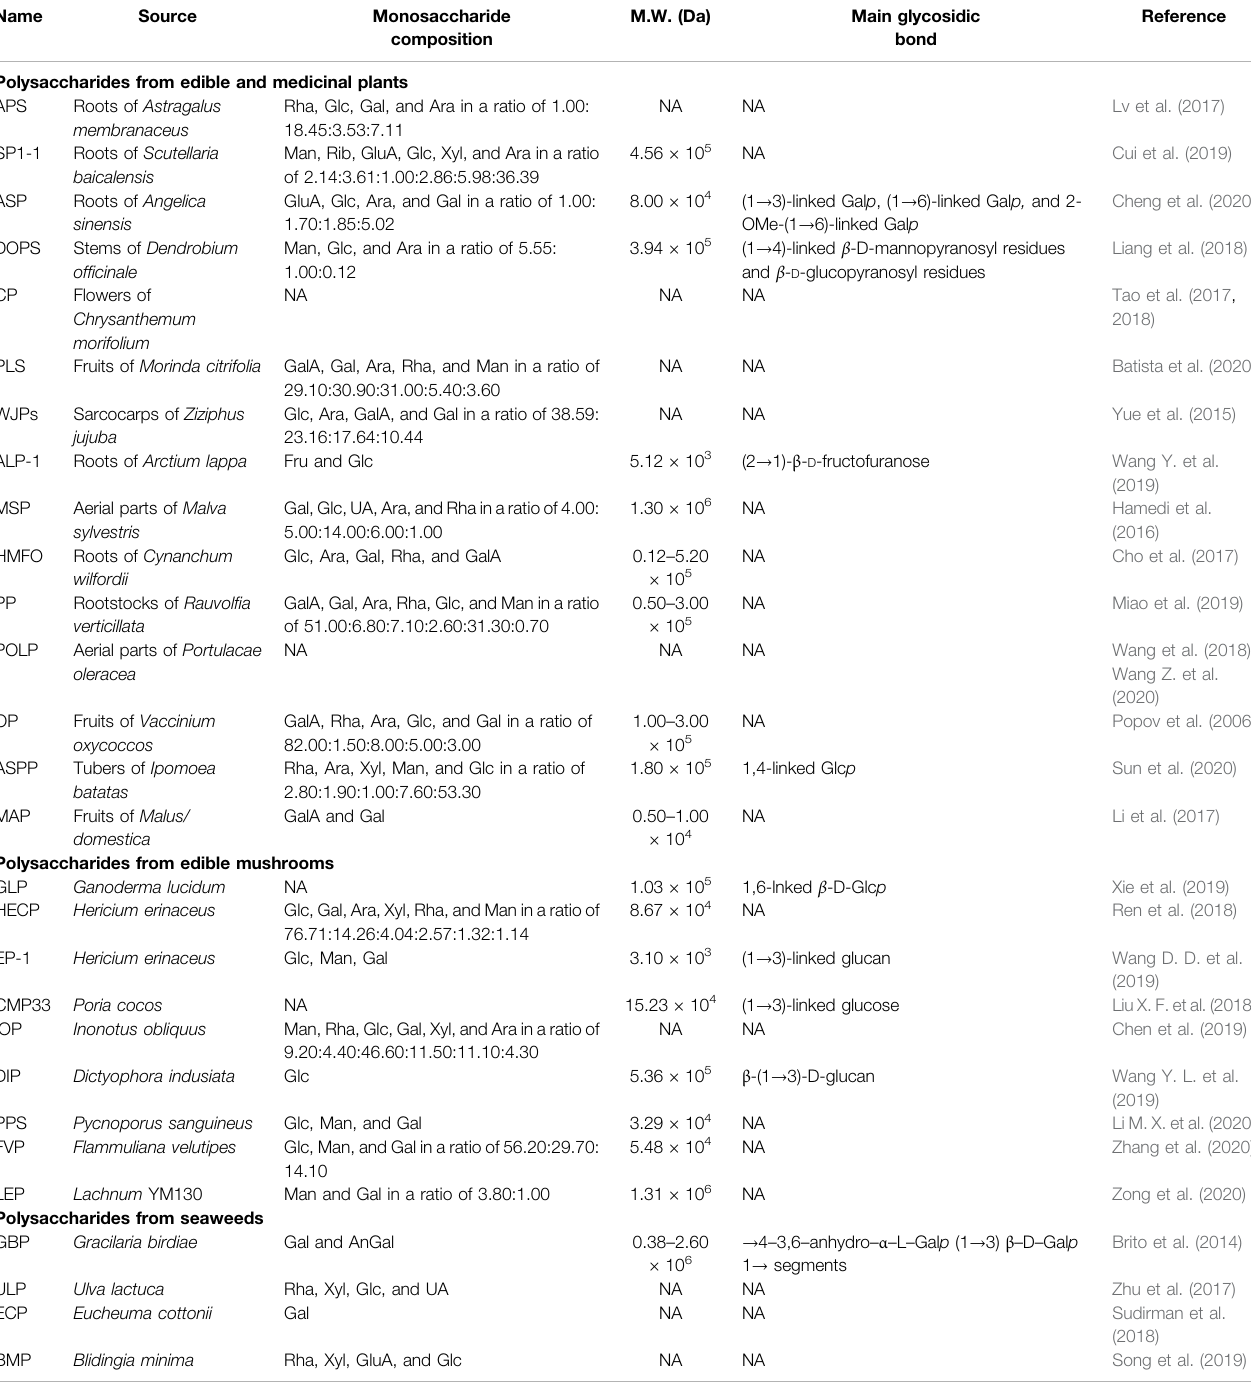
TABLE 2 | Monosaccharide composition, molecular weight, and main glycosidic bond of polysaccharides from natural